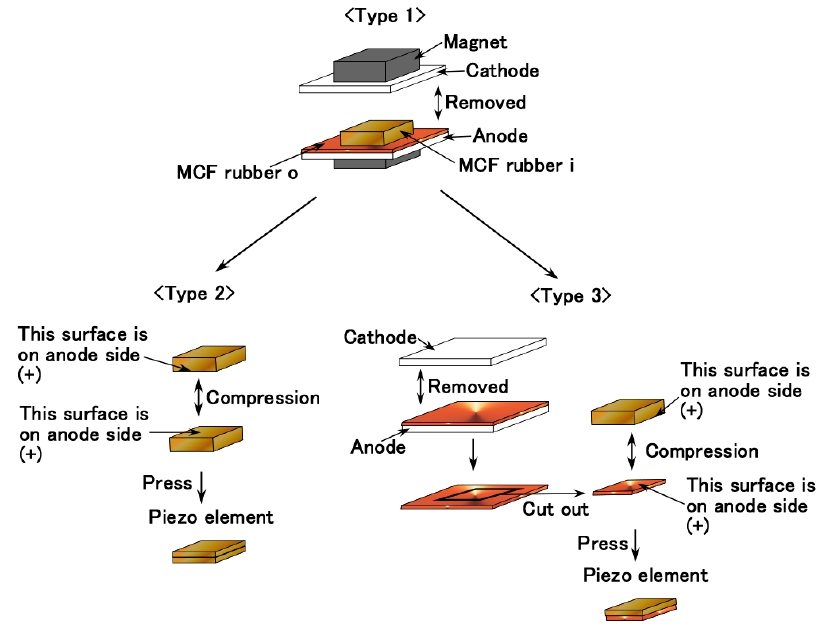
Figure 2. Production of layered piezoelements utilizing MCF rubber vulcanized by the application of electric and magnetic fields.